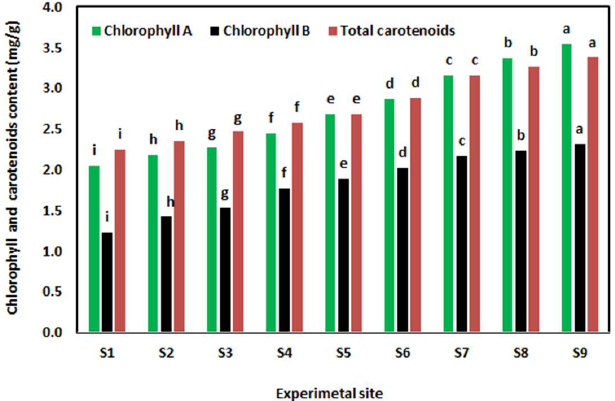
Figure 1. Distribution of mean values of chlorophyll A, chlorophyll B, and total carotenoids contents in leaves of Flame Seedless grape cultivated by different agricultural practices in investigated vineyards [different letters indicate that means are significantly different from each other ( p < 0.05)].